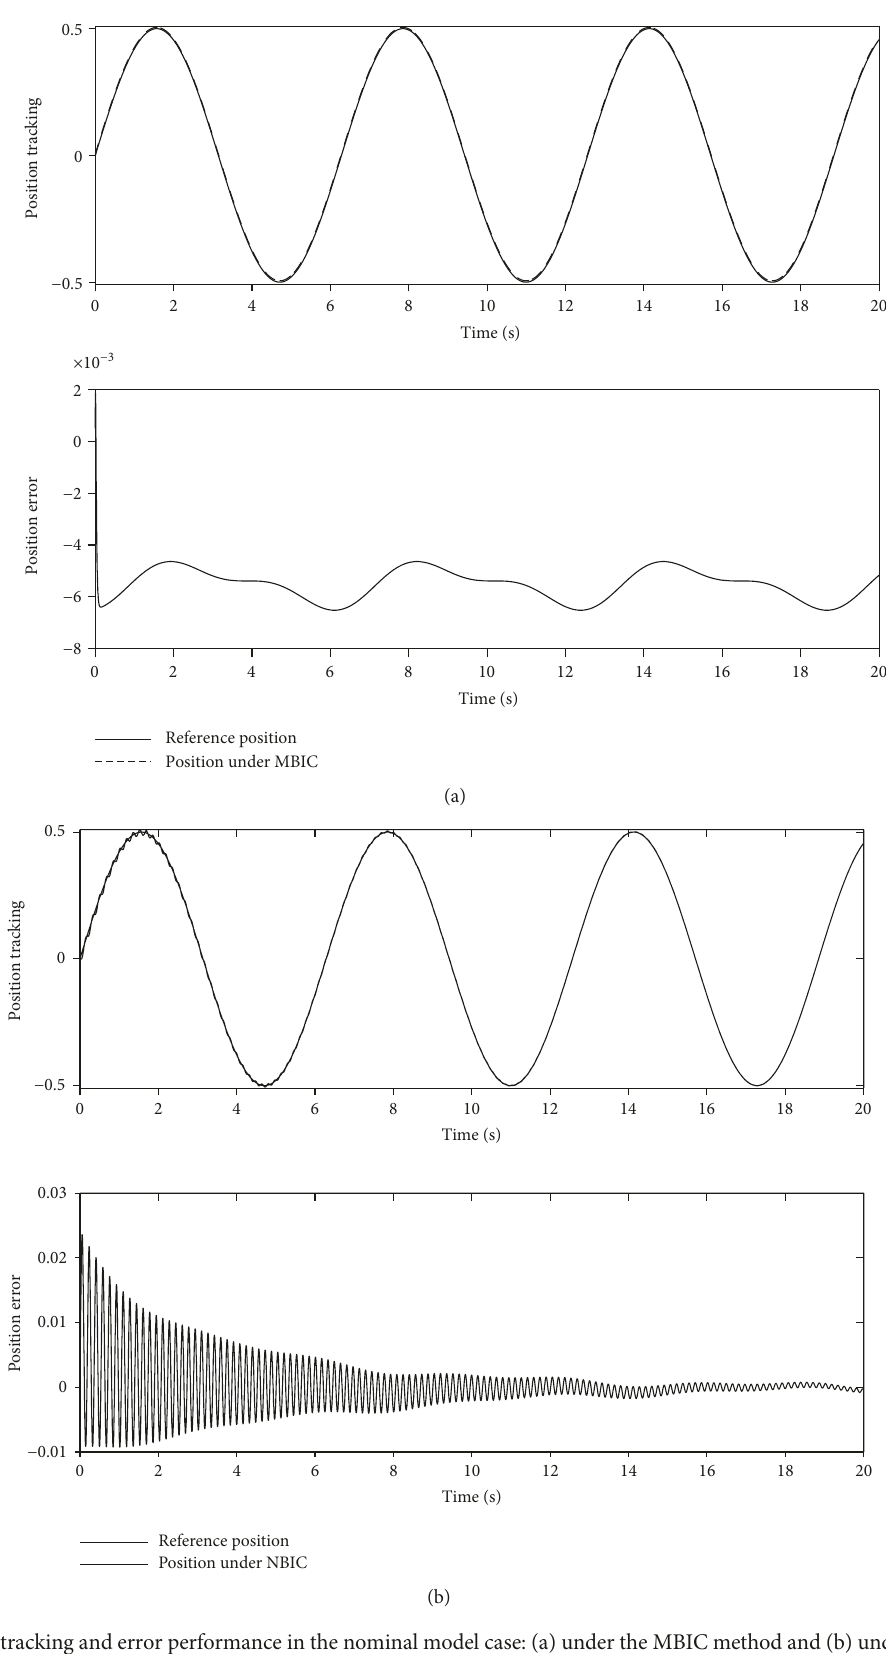
Figure 4: Position tracking and error performance in the nominal model case: (a) under the MBIC method and (b) under the NBIC